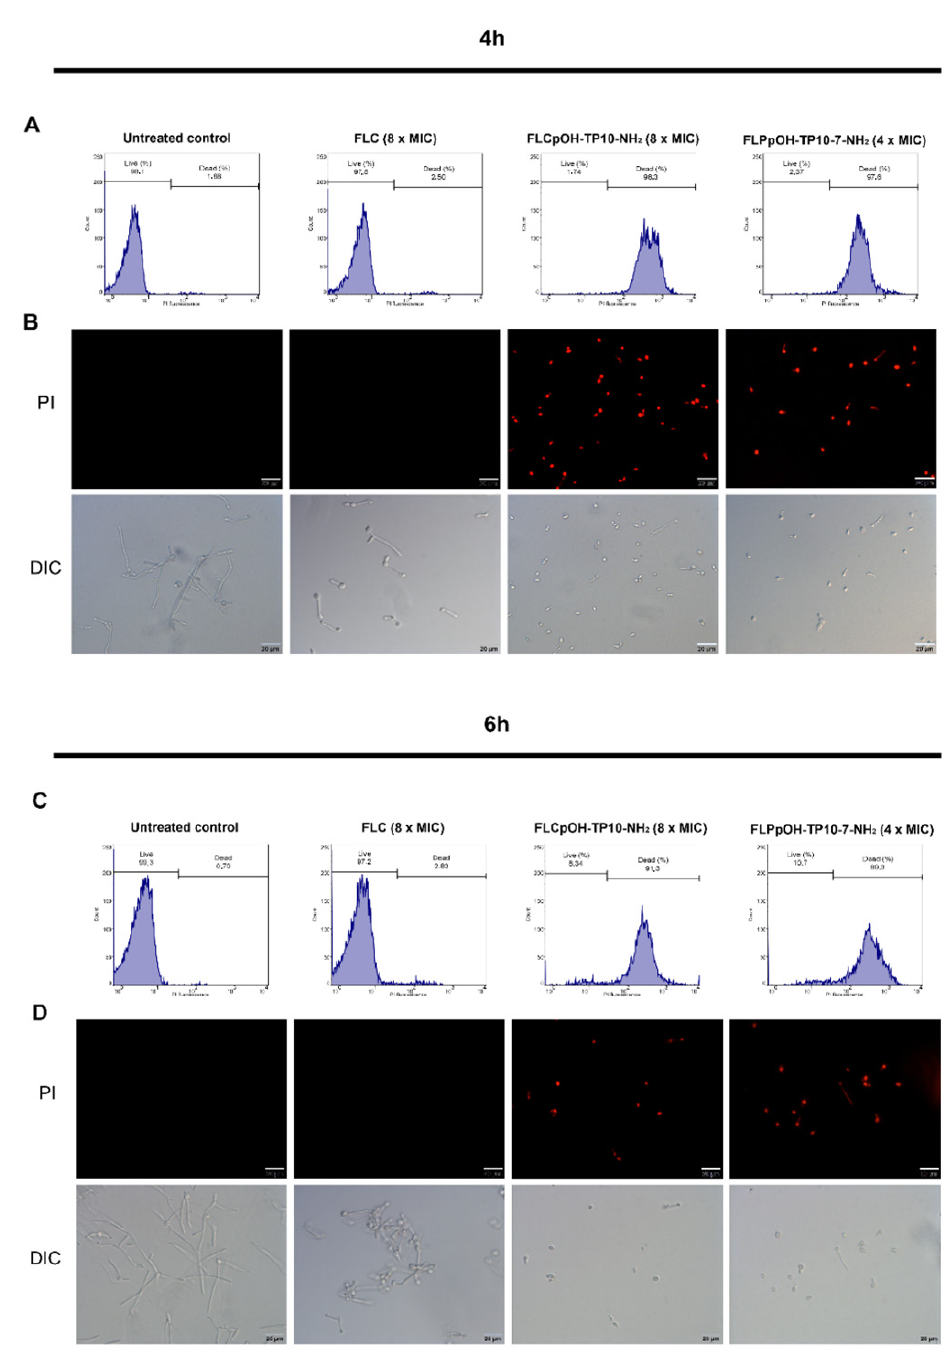
Figure 3. ( A , C ) Flow-cytometric analysis of membrane permeabilization assay by PI uptake. Cells were treated with FLC and FLC conjugates and stained with PI. After the completion of treatment and staining process, the cellular fluorescence was then analyzed via flow cytometry. ( B , D ) Fluorescence microscopy analysis of membrane permeabilization assay by PI uptake in treated as well as untreated yeast cells. The results of selected images are chosen as the best representatives of one of three different experiments with two replicates; similar results were observed each time. DIC—differential interference contrast microscopy, PI—fluorescence microscopy. Scale bars correspond to 20 µ